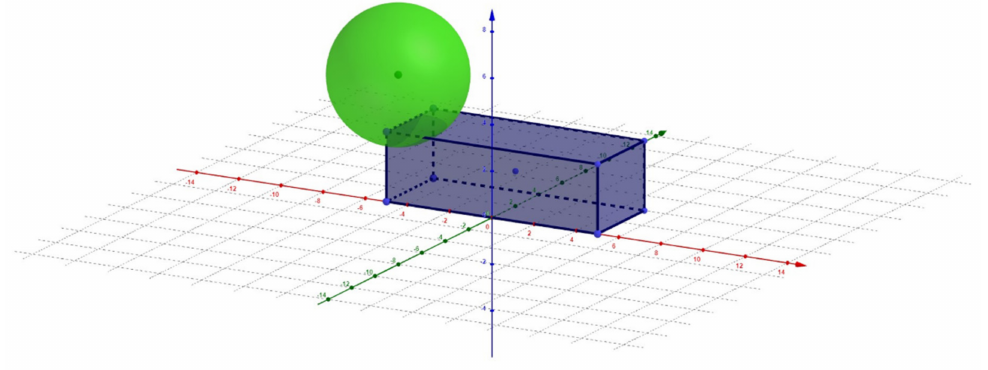
Figure 8. Simplified representation of the interaction between a sphere and a rectangular